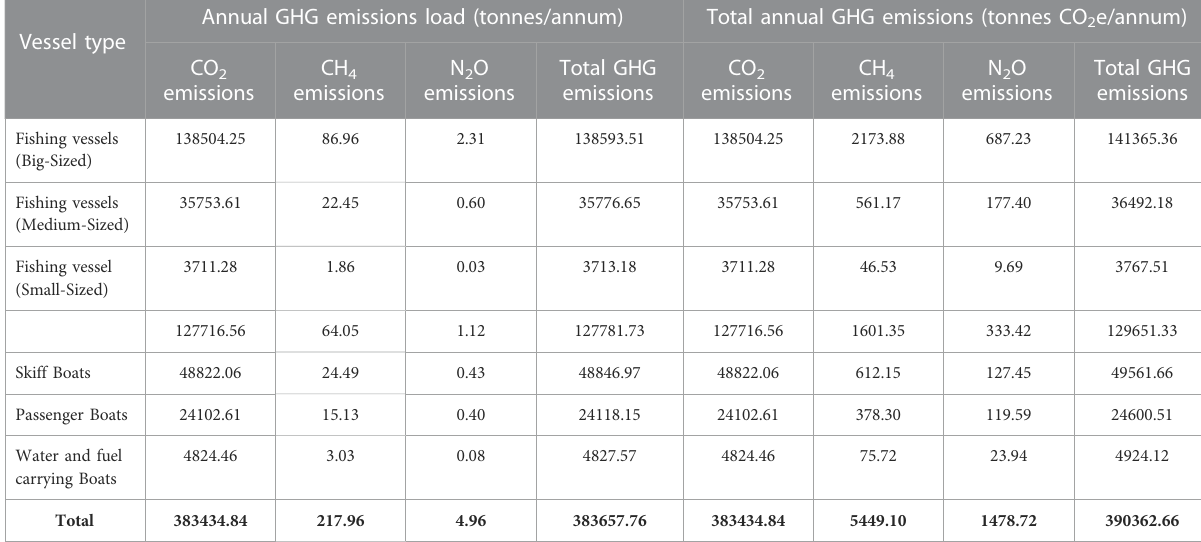
TABLE 14 Breakdown of GHG Emissions from fi shing and other crafts in Balochistan, Pakistan.